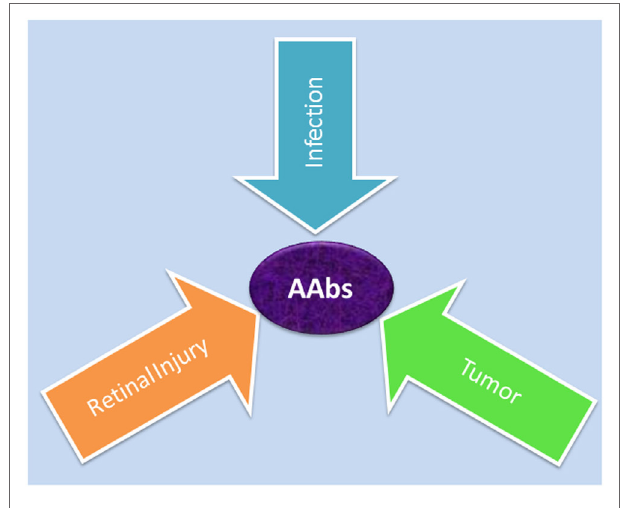
FigURe 2 | Possible causes for generation of autoantibodies reacted with retinal antigens: anti-microbial responses (infection) against similar antigens released after infection, antitumor responses (tumor) against upregulated similar proteins, or anti-retinal responses to released sequestered proteins (retinal injury) from dying retinal